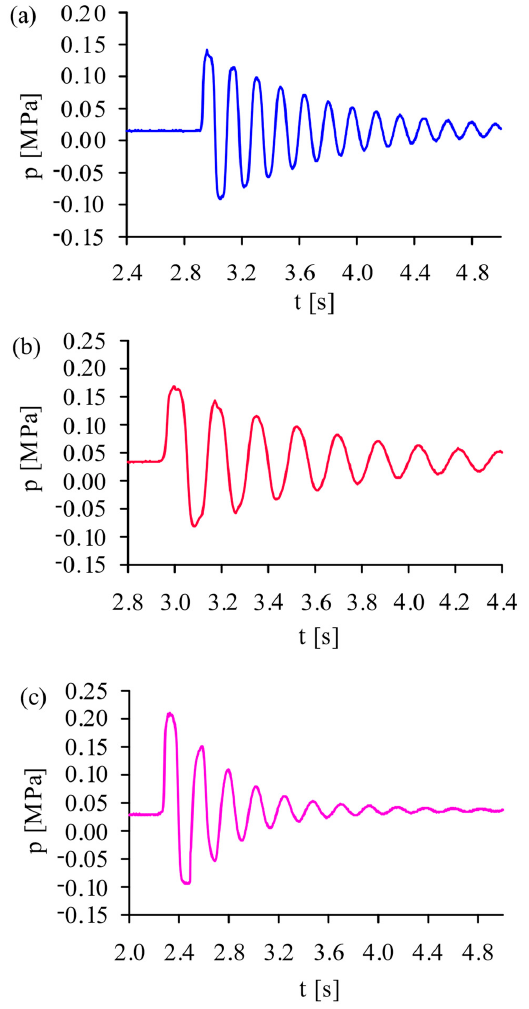
Figure 3. Measured pressure characteristics of transient flow: ( a ) water; ( b ) slurry, C V = 0.007; ( c ) slurry, C V = 0.039.